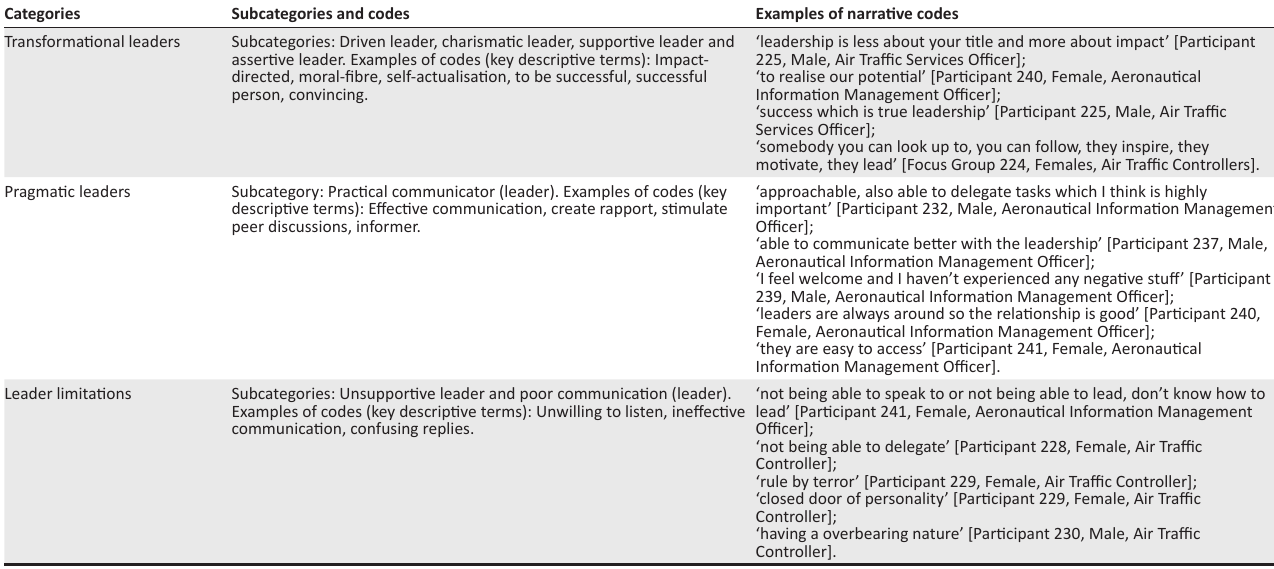
TABLE 1: Categories and associated subcategories (individual interviews).